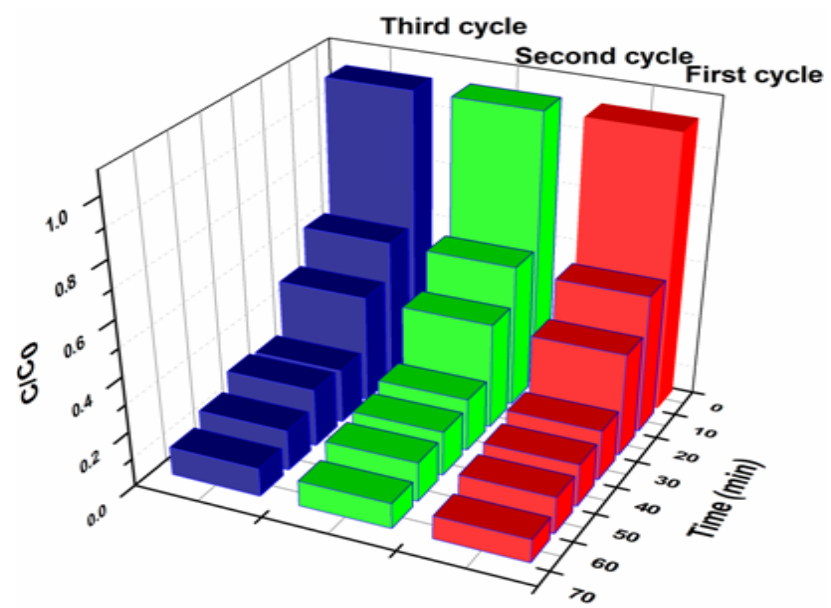
Figure 10. The reusability of ZnO/C 3 N 4 for the photodegradation of RhB.